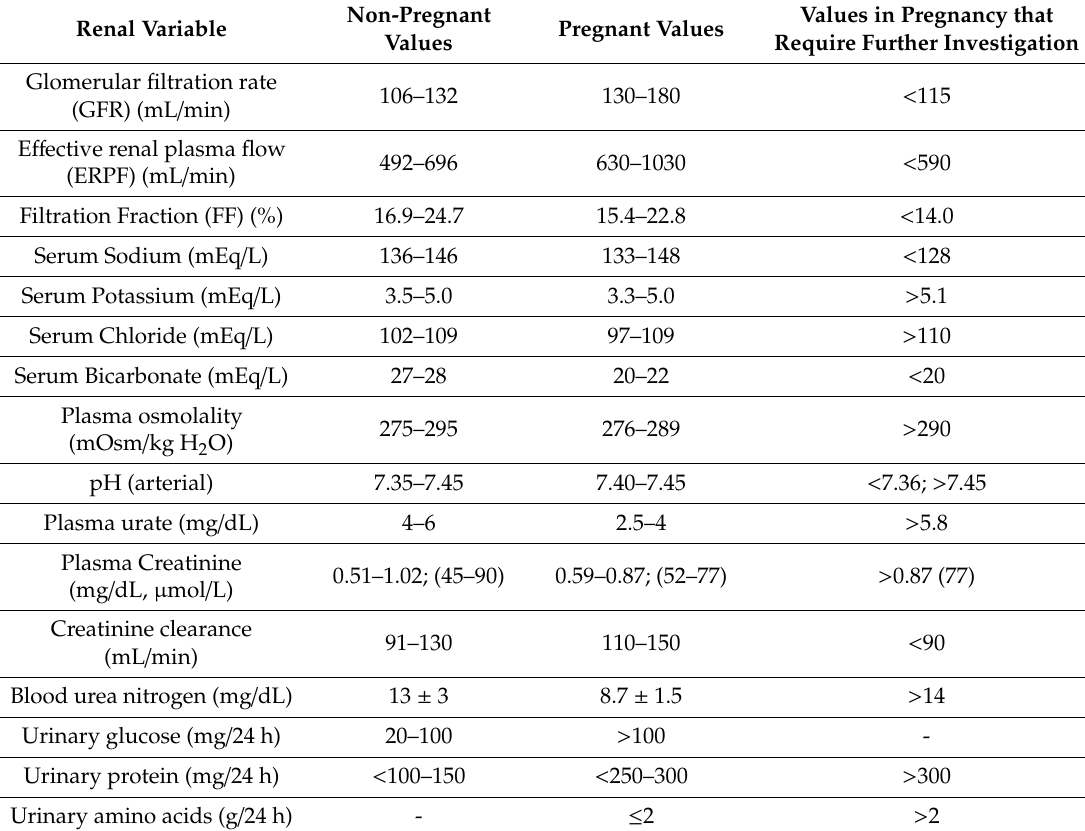
Table 2. Laboratory values of renal function in pregnancy. Adapted from references [20–23]. Pregnant values of each variable are means of the variable values measured throughout